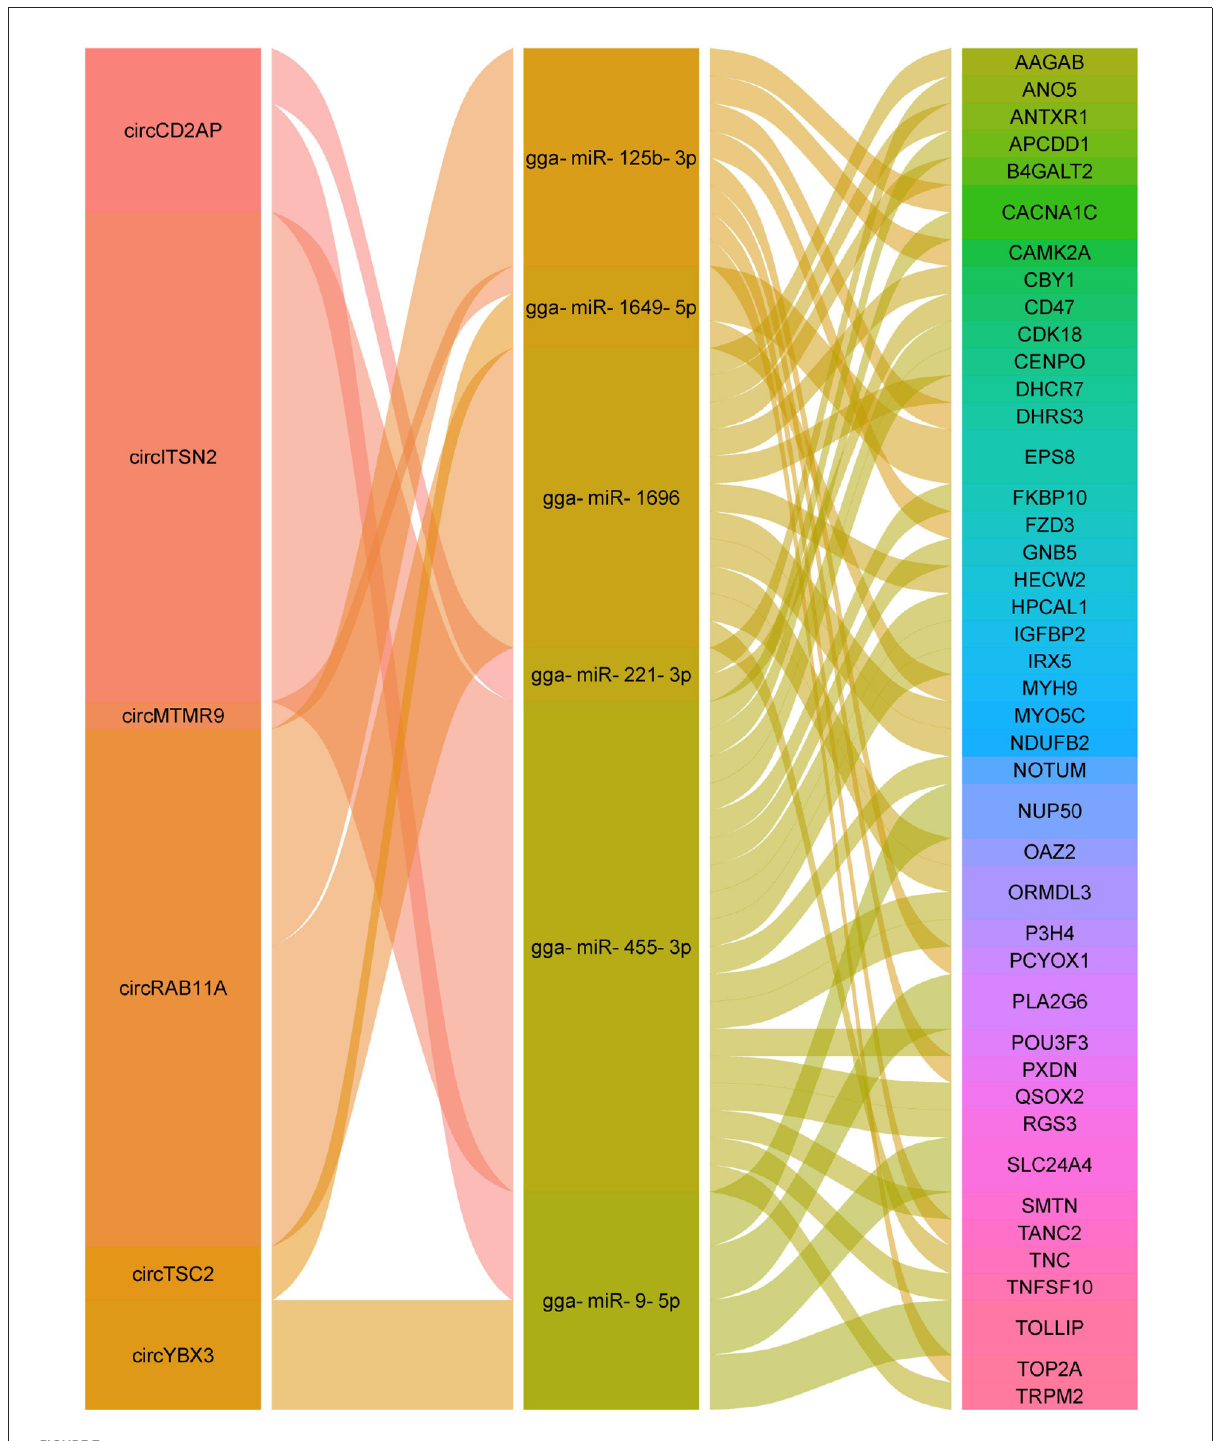
FIGURE7 Alluvial plot of the circRNA-miRNA-mRNA interactions network.